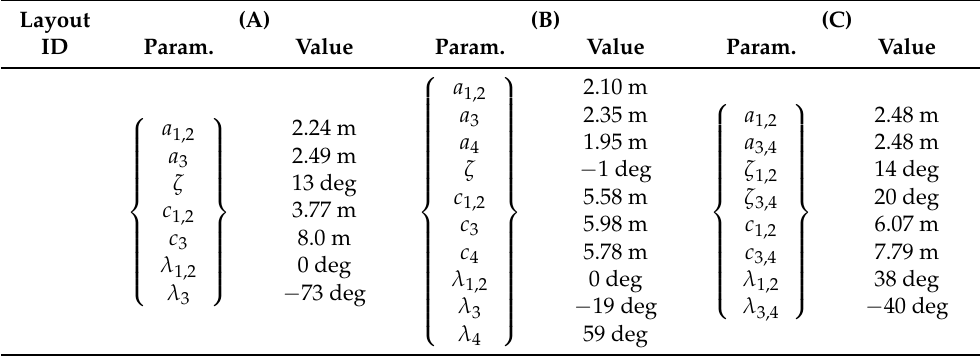
Table 4. Optimal results from global optimizations, for the three considered layouts.